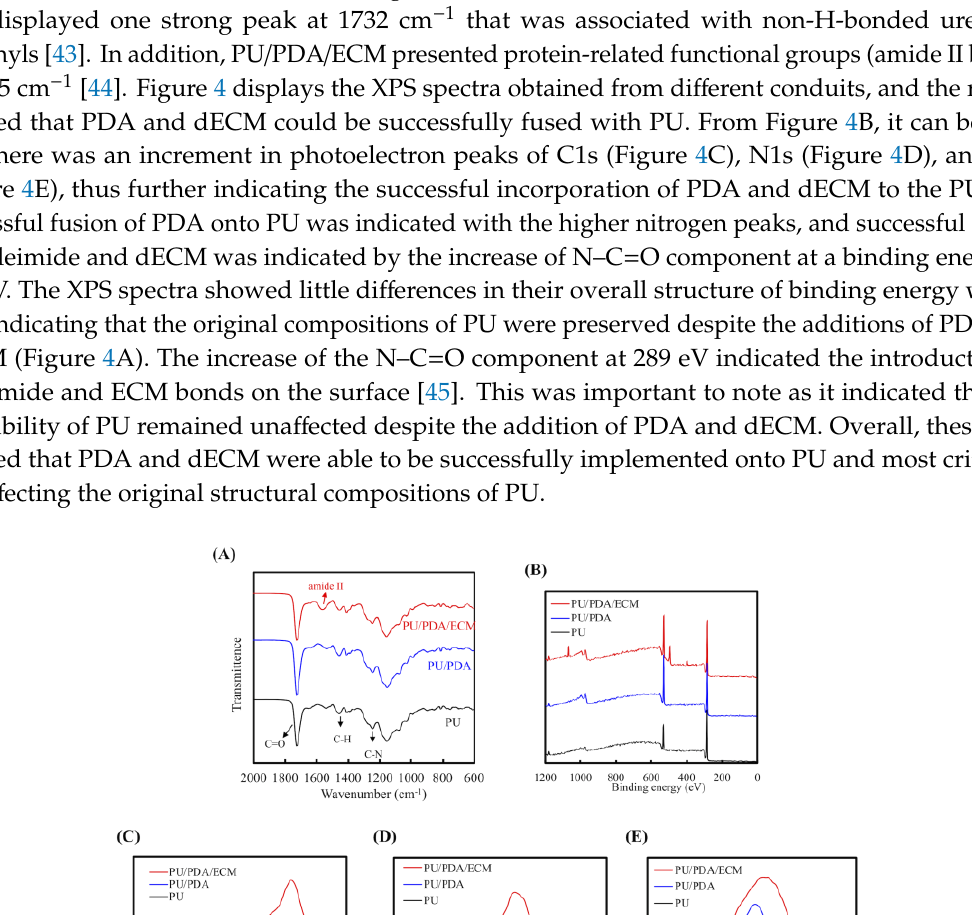
Figure 4. ( A ) FTIR spectra, ( B ) XPS, ( C ) C1s, ( D ) N1s, and ( E ) O1s high-resolution spectra of PU, PU/PDA, and PU/PDA/ECM composites.